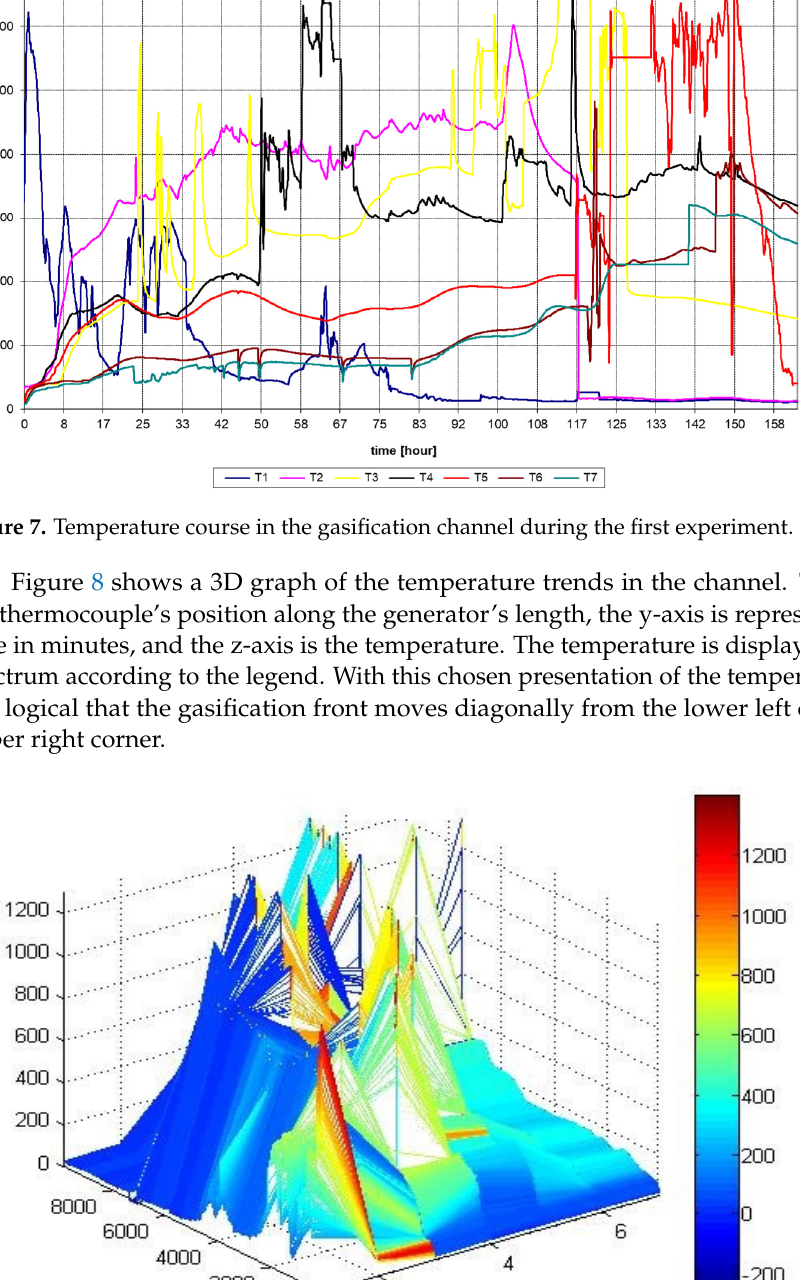
Figure 8. Time profile of the temperatures in the gasification channel along the length of the gener- ator for the first experiment.